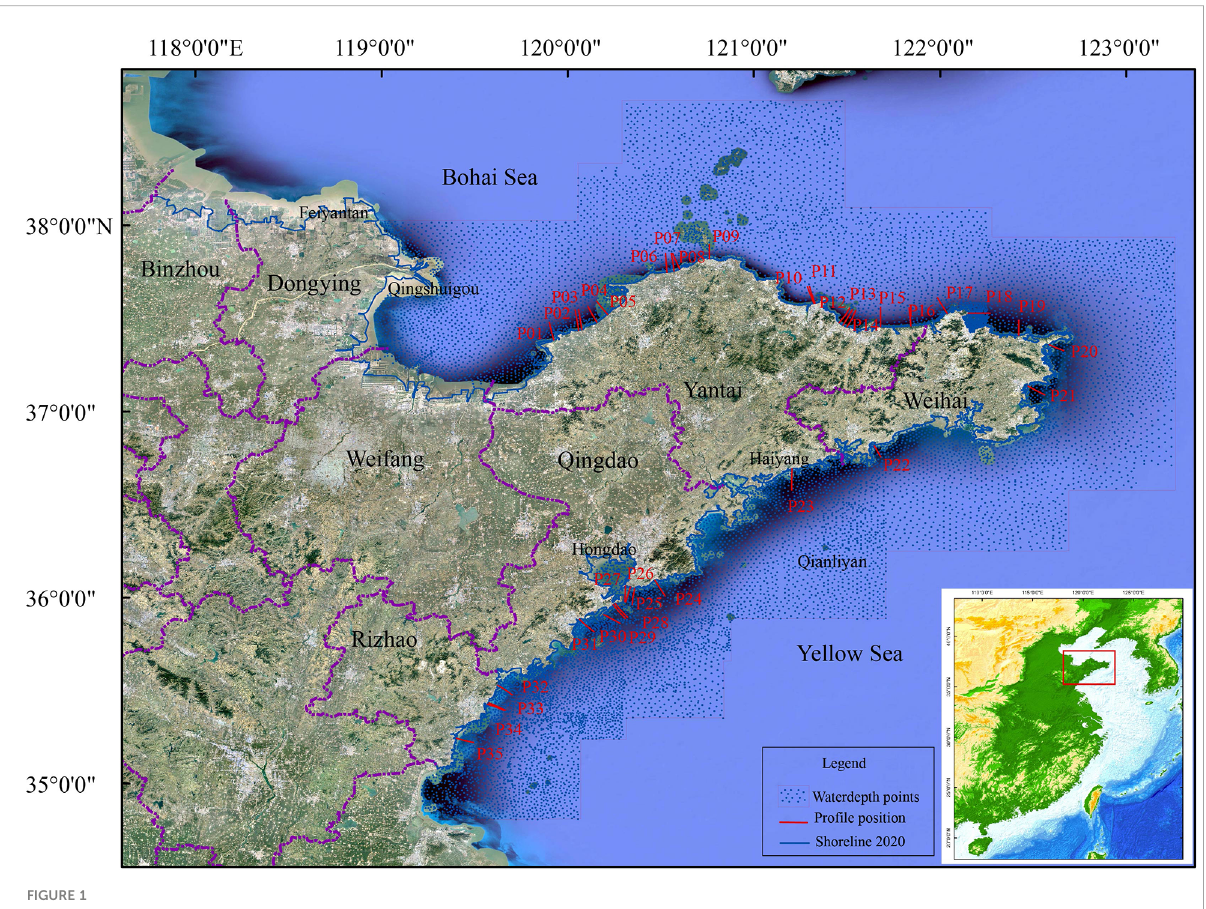
FIGURE 1 Location and satellite image of the Shandong